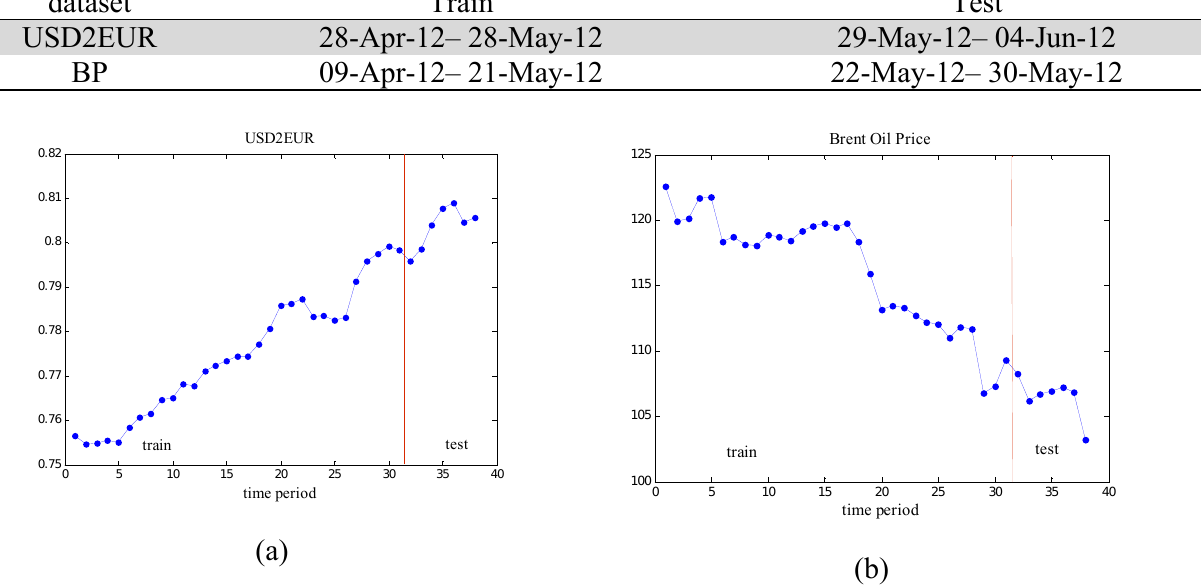
Fig. 3 . (a) The pattern of Brent oil price and (b) USD2EUR exchange rate